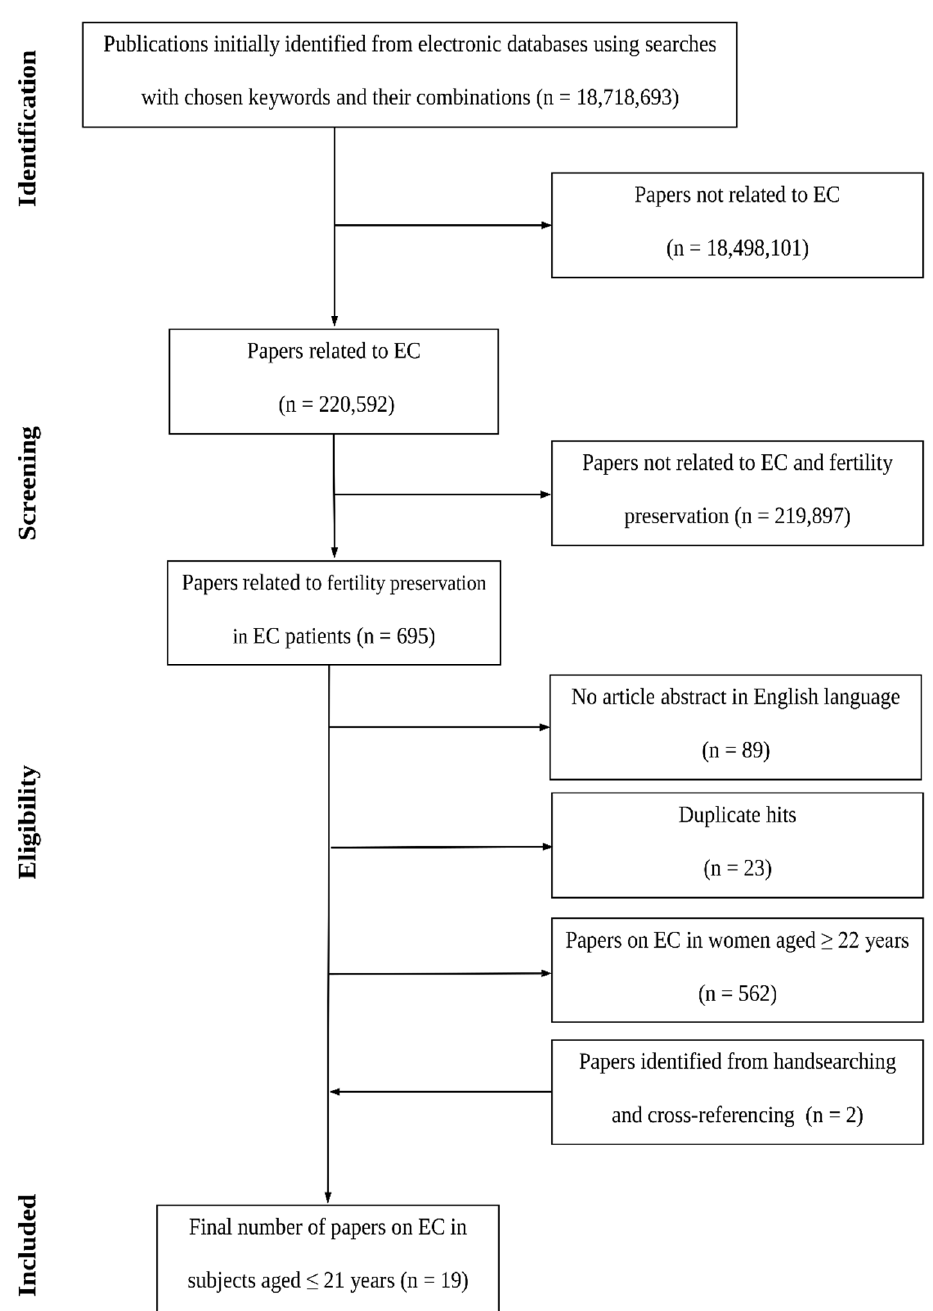
Figure 1. Study selection process for the systematic review of cases of endometrial cancer (EC) in subjects aged 21 years and younger.